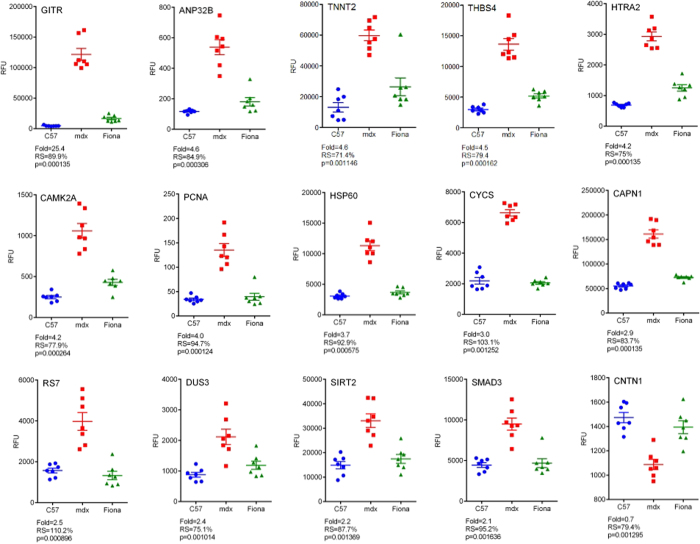
Top candidate biomarkers in dystrophic and Fiona serum.Protein abundance per individual biological replicate was plotted for the top 15 ranked candidate biomarkers identified by SOMAscan. mdx vs C57 fold changes, Recovery score (RS) in Fiona compared to mdx and C57, Kruskal-Wallis one-way ANOVA p values are indicated for each protein. Error bars indicate mean +/− SEM.